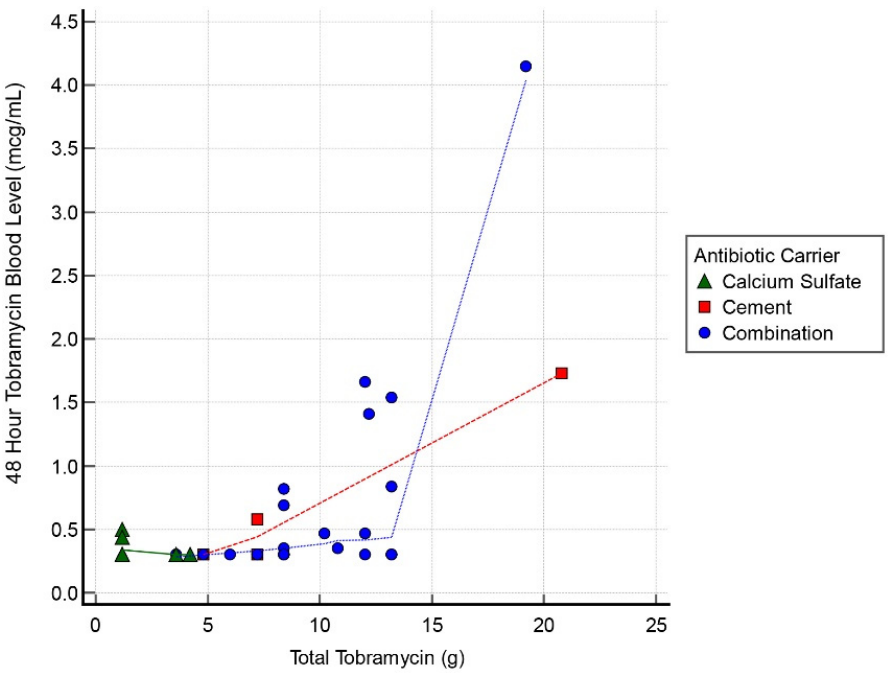
Figure 2. Scatter graph of tobramycin blood level (mcg/mL) and total tobramycin (g) at 48 h inter- val.